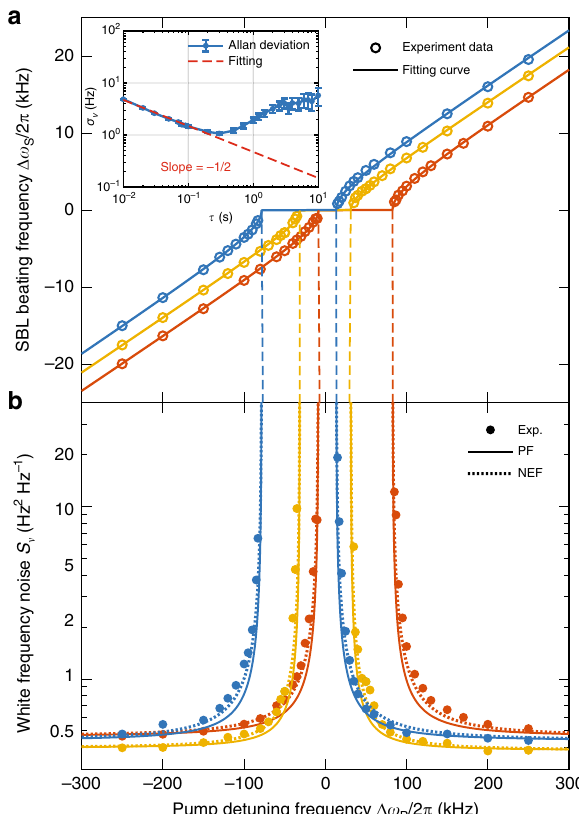
Fig. 2 Measured linewidth enhancement of SBLs near the exceptional point. a Measured SBL beating frequency is plotted versus pump detuning for three distinct locking zones, corresponding SBL amplitude ratios q : 1.15 (blue), 1 (orange), 0.85 (red). Solid curves are theoretical fi ttings. Inset is a typical Allan deviation measurement of frequency ( σ ν ð τ Þ ) versus gate time τ . Error bars give the standard error of the mean. The short-term part ffiffiffiffiffiffiffiffiffiffiffiffiffiffiffiffi p S = ð 2 τ Þ is fi tted with where S ν is the one-sided power spectral density of ν the white frequency noise plotted in b . b Measured white frequency noise of the beating signal is determined using the Allan deviation measurement. Data point color corresponds to the amplitude ratios used in a . The Petermann factor PF (solid lines) and NEF (dashed lines) theoretical predictions use parameters obtained by fi tting from a white frequency noise. Adev measurement at each of the detuning points in Fig. 2a is used to infer the S ν values that are plotted in Fig. 2b. There, a frequency noise enhancement is observed as the